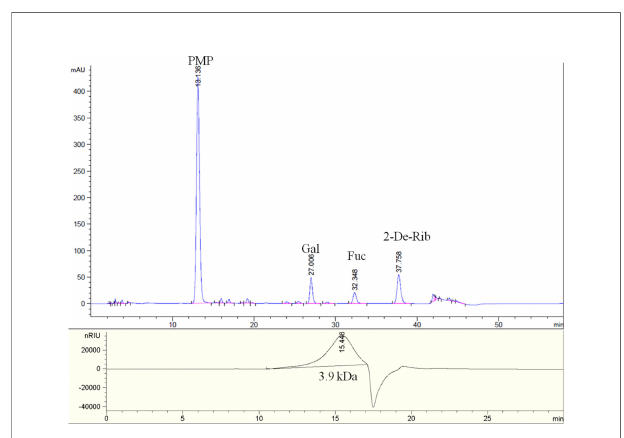
FIGURE 1 | The PMP derivatization HPLC spectrum (top) and GPC-HPLC spectrum (bottom)